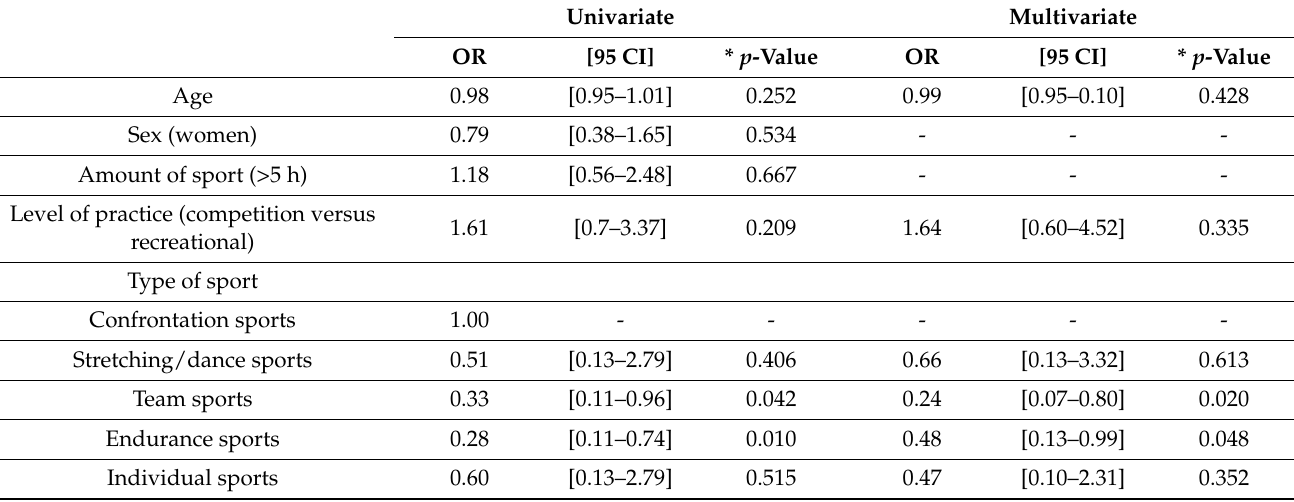
Table A3. Association between borderline patients and sport